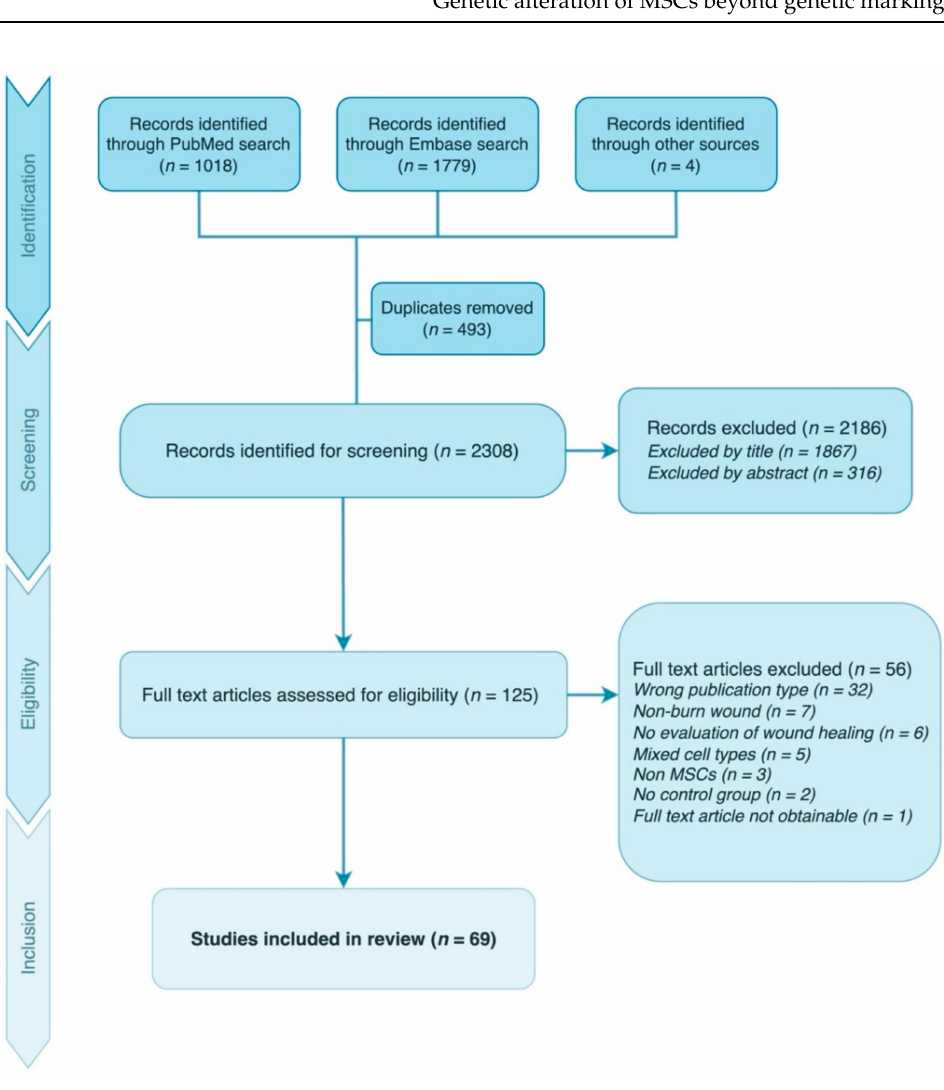
Figure 1. Illustration of the study selection